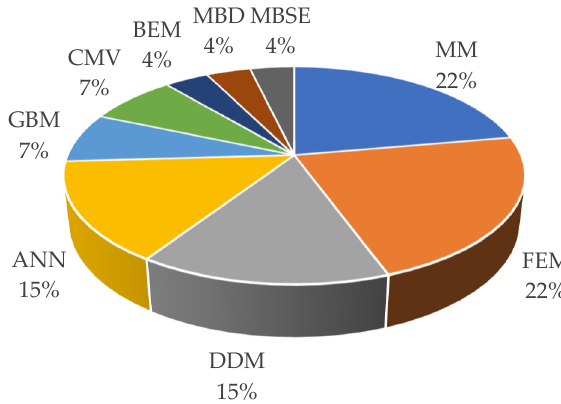
Figure 5. Modelling methods review.